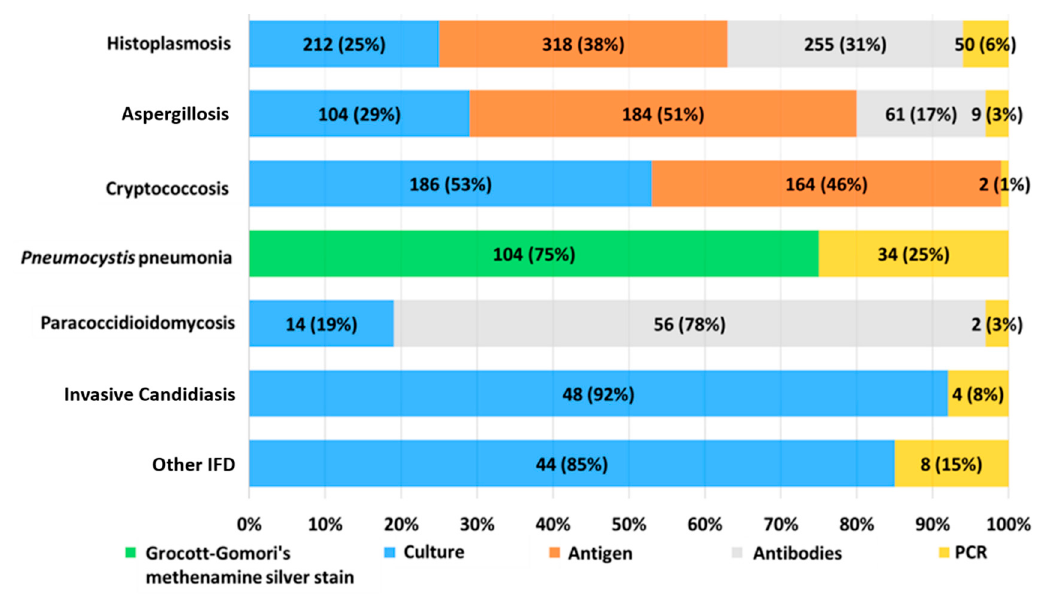
Figure 1. Frequency of positivity among laboratory assays used in the diagnosis of invasive fungal diseases.